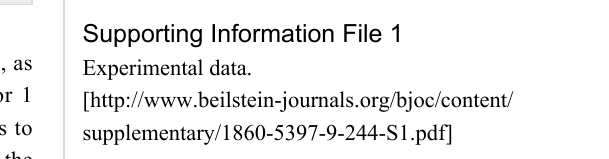
Figure 5: IR sensor 1, NMP, 1